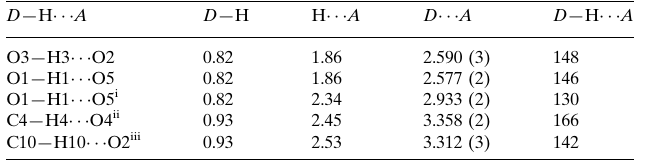
Hydrogen-bond geometry (A˚ , (cid:2)